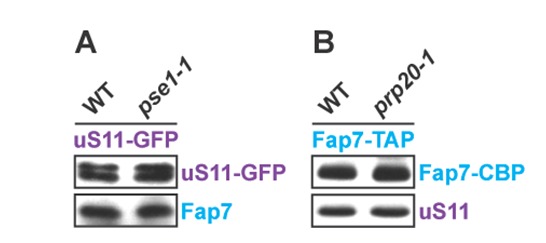
(A) Wild-type and pse1-1 strains expressing uS11-GFP were grown in synthetic media at 25°C to mid-log phase and then shifted to 37°C for 4 h. uS11-GFP was then immuno-precipitated and subjected to Western analysis.(B) Wild-type and prp20-1 strains expressing Fap7-TAP were grown in synthetic media at 25°C to mid-log phase and then shifted to 37°C for 4 h. Fap7-TAP was then purified and subjected to Western analysis.